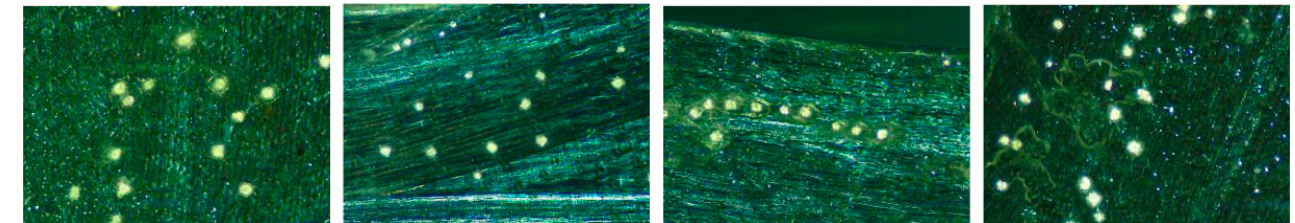
Figure 5. Sample of images in the dataset including diffraction images of calcium oxalate crystals on grape leaves under polarized light (10×). Calcium oxalate crystals are visible as bright spots. The size of the crystals in the dataset is in the range from 3000 µm 2 to 6000 µm 2 , and the size of the leaf portion is 0.5 cm × 0.5 cm.